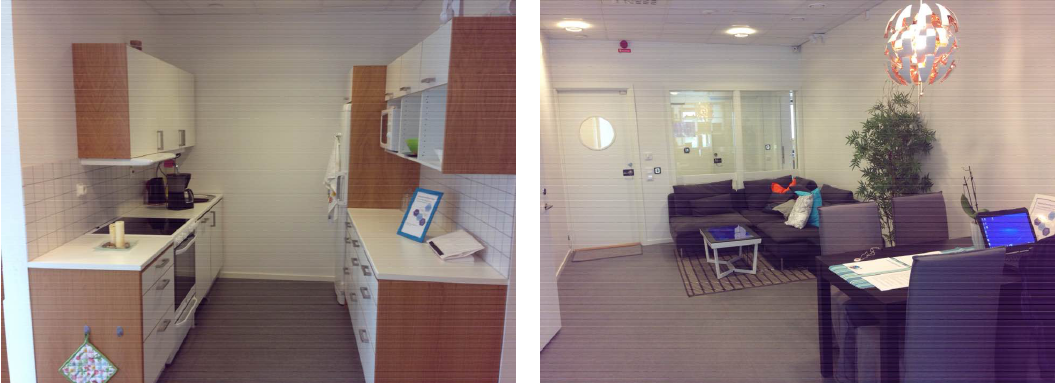
Figure 1. ( Left ) The Halmstad Intelligent Home (HINT) kitchen. ( Right ) The dining and living rooms at Halmstad Intelligent Home